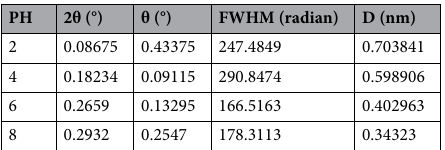
Table 1. Parameters of crystal calculated from XRD data.